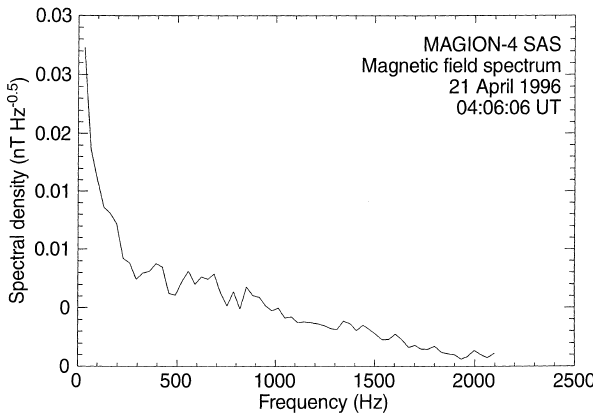
Fig. 7. The spectrum of the magnetic-field (B x -component) fluctua- tions at the leading edge of the cusp